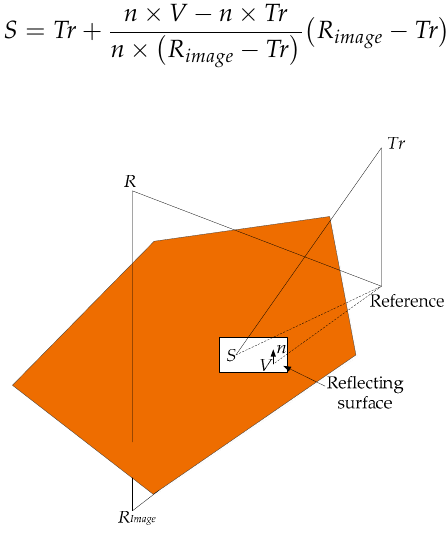
Figure 9. Geometric reflection model.